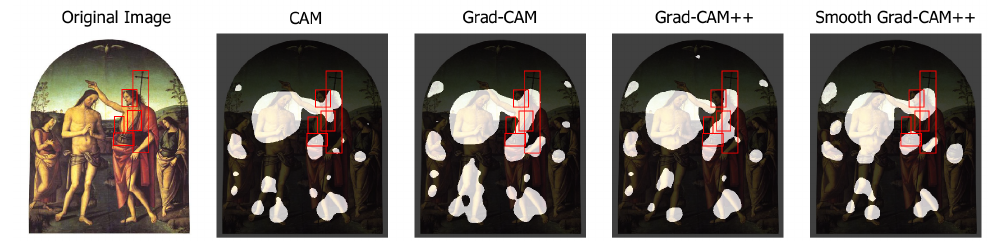
Figure 18. Class activation maps with confusion between Saint John the Baptist and Jesus